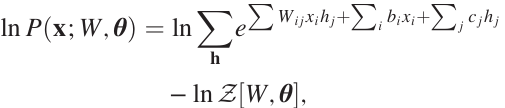
FIG. 1. Factor-graph representation of the RBM distribution. Variables are indicated by circles, with latent variables denoted by shaded circles. The shaded rectangles indicated layer partitions within the RBM structure. Factors are represented by squares, with the right-hand side factors representing the pairwise relation- ships between variables and the left-hand side factors represent- ing the influence of the localized prior distributions on the